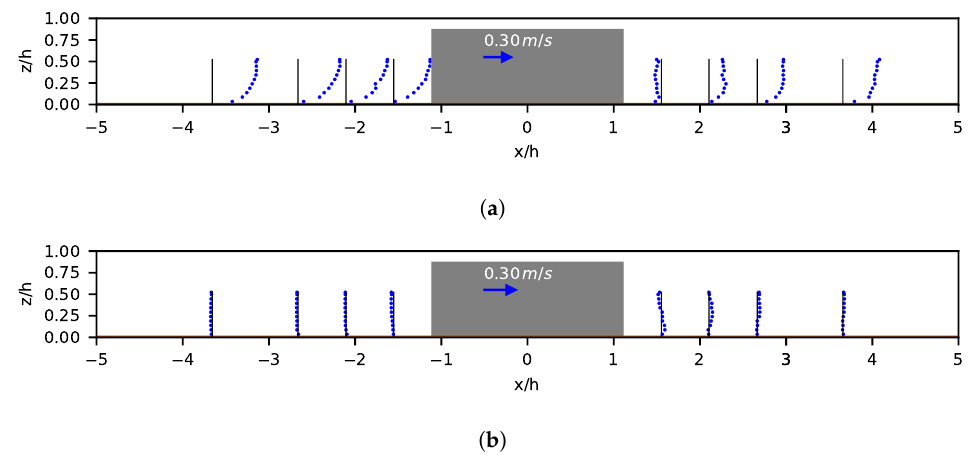
Figure 9. Vertical profiles of the velocity components along the pier’s mid-plane for Exp . 2 U Fbed . ( a ) Stream-wise component of velocity ( u ). ( b ) Vertical component of velocity ( w ). In Exp . 1 U Fbed , the maximum stream-wise component of velocity, u , occurred for an elevation ( z ) equal to 0.097 m in all the vertical profiles at the upstream side of the oblong pier ( Pier 11); the magnitude reached a maximum value of 0.377 ms − 1 (skewness and kurtosis coefficients of − 0.70 and 1.02, respectively) for the vertical profile “1” of the A half- plane (situated 0.5 m upstream from the pier front edge, Figure 4), whereas a magnitude of 0.313 ms − 1 (skewness and kurtosis coefficients of 2.55 and 39.43, respectively) was attained for the vertical profile “4” of the A half-plane (at roughly 0.09 m upstream from the pier front edge. For Exp . 2 U Fbed , those values registered a maximum of 0.509 ms − 1 and 0.422 ms − 1 for the vertical profiles “1” and “4” of A , respectively. The corresponding computed skewness and kurtosis coefficients were − 0.94 and 2.31 for vertical profile “1” and − 1.99 and 17.42 for vertical profile